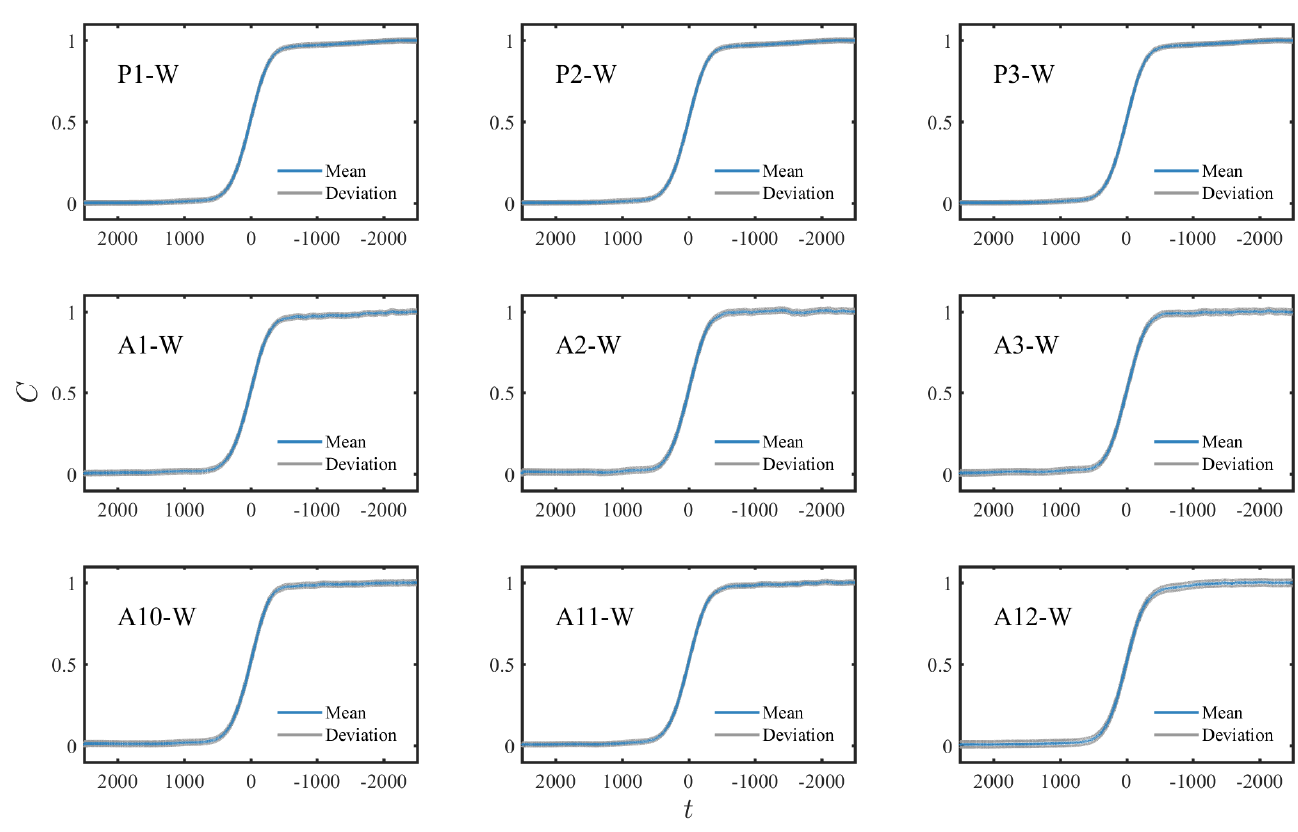
Figure A1. Experimental error estimate for five repeated runs. The blue curve is the mean of the experiments that measured at the west (W) branch at each location and the gray curve is the average